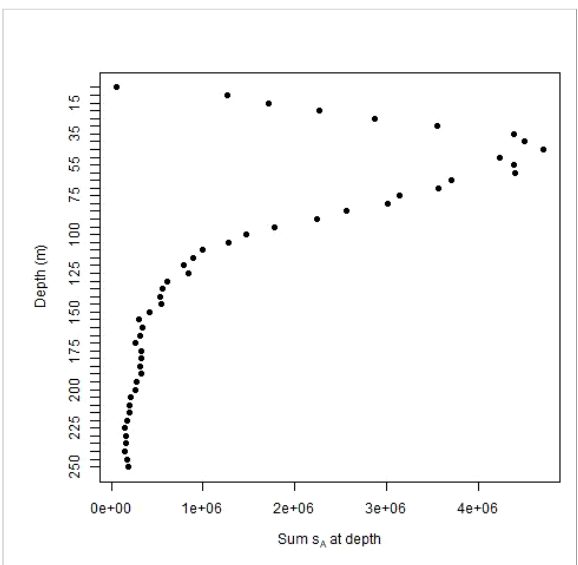
FIGURE 3 Mean nautical area scattering coef fi cients (s A ) in fi fty 5 m depth bins of the 20 populations being sampled by simulated gliders for both strata and all years